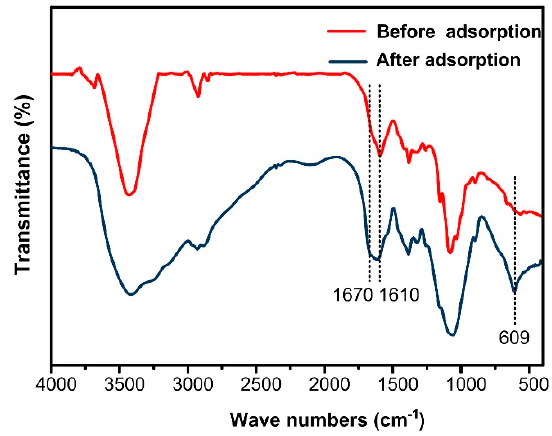
Figure 12. FT-IR spectra of CS membranes before and after adsorption of Cu(II).